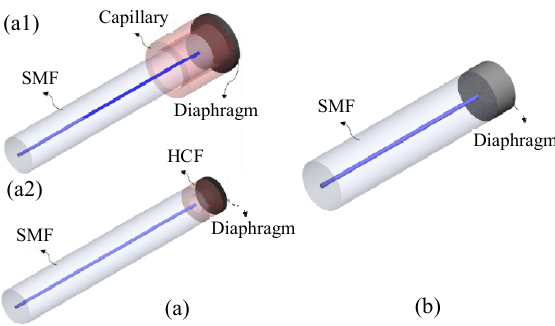
Fig. 16 Schematic diagrams of the D-EFPI structure when the diaphragm functions as (a) the second reflective surface and (b) FP